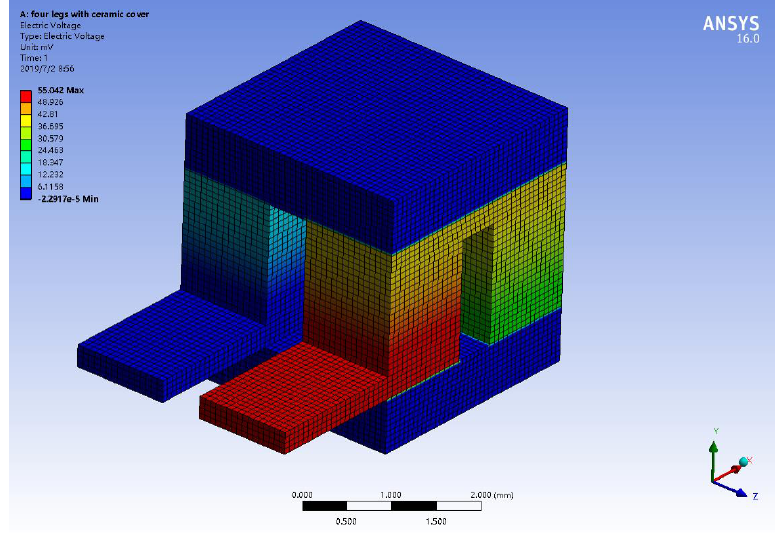
Figure 5. Voltage distribution in the thermoelectric system.